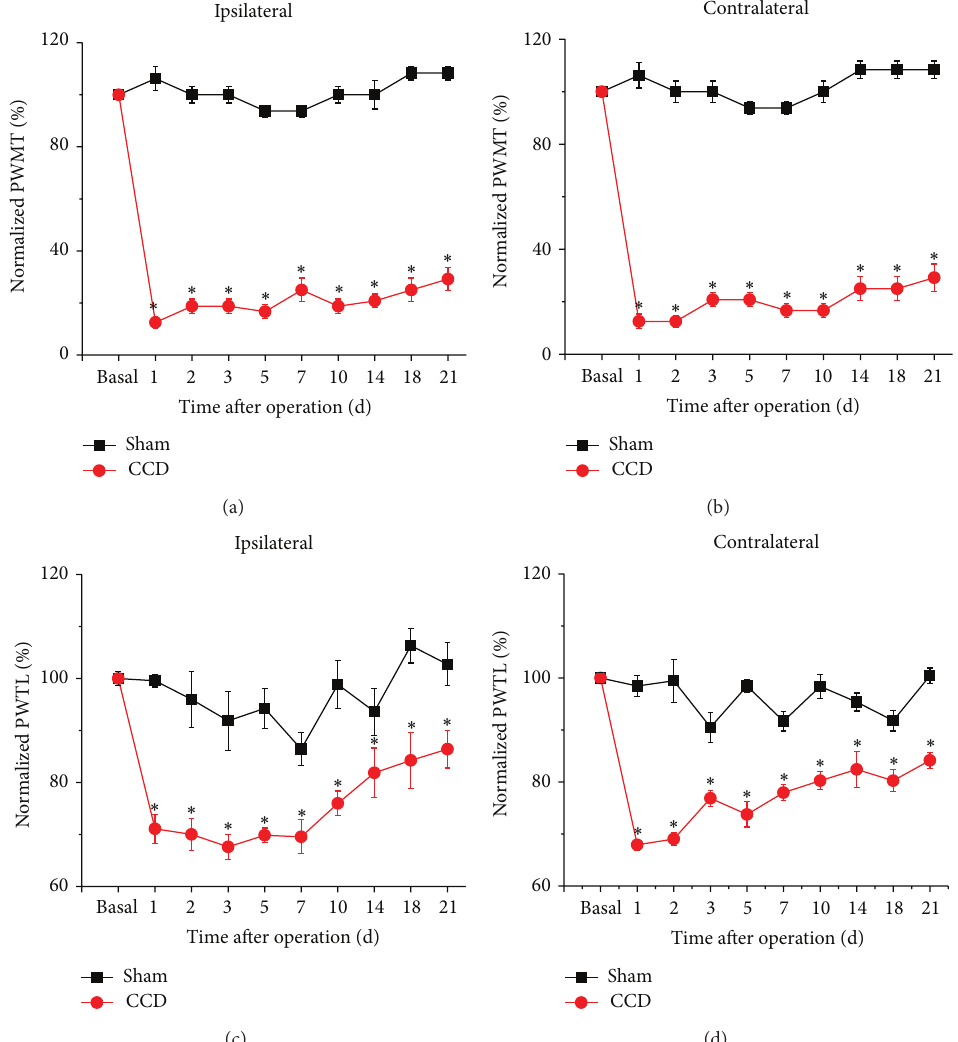
Figure 3: Development of mechanical hypersensitivity and thermal hyperalgesia following chronic compression of DRG (CCD) in rats. (a-b) Mechanical hypersensitivity developed in CCD rats but not in sham controls for both ipsilateral (a) and contralateral hindpaws (b). Note that paw withdrawal mechanical threshold (PWMT) to von Frey hairs decreased dramatically from the 1st day following chronic compression of L5 DRG ( 𝑛 = 10 ; 𝑃 < 0.05 ). (c-d) Thermal hyperalgesia was observed by measuring paw withdrawal thermal latency (PWTL) to radiant heat in CCD rats and sham controls for both ipsilateral (c) and contralateral hindpaws (d). Note that PWTL significantly decreased in CCD rats ( 𝑛 = 10 ; 𝑃 < 0.05 ) but not in sham group ( 𝑛 = 10 ; 𝑃 > 0.05 ) with a similar time course with mechanical hypersensitivity. All data are expressed as mean ±